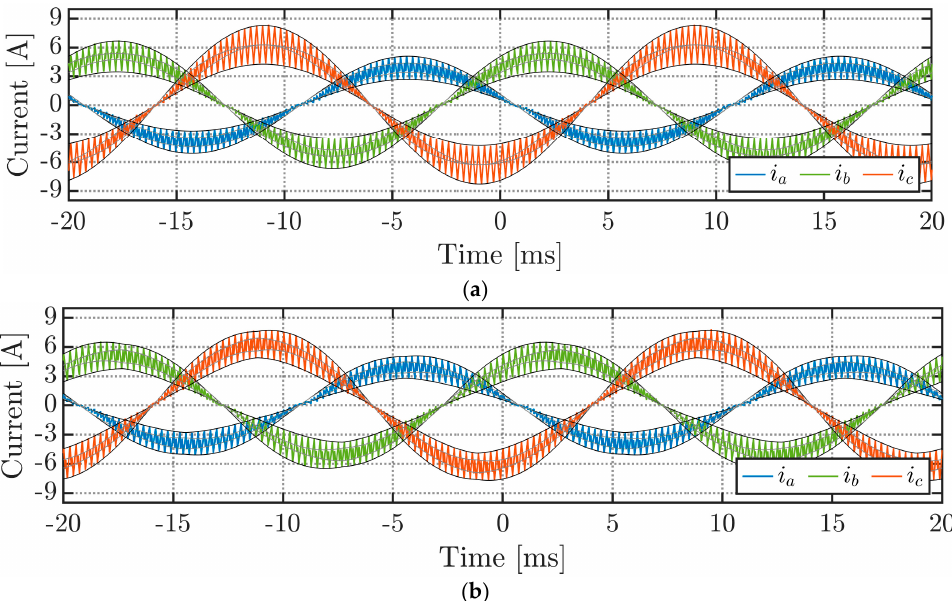
Figure 16. Instantaneous phase currents for a magnitude unbalanced case with their primary (black) and secondary (gray) current ripple envelopes for SPWM ( a ) and CPWM ( b ) modulation strategies.